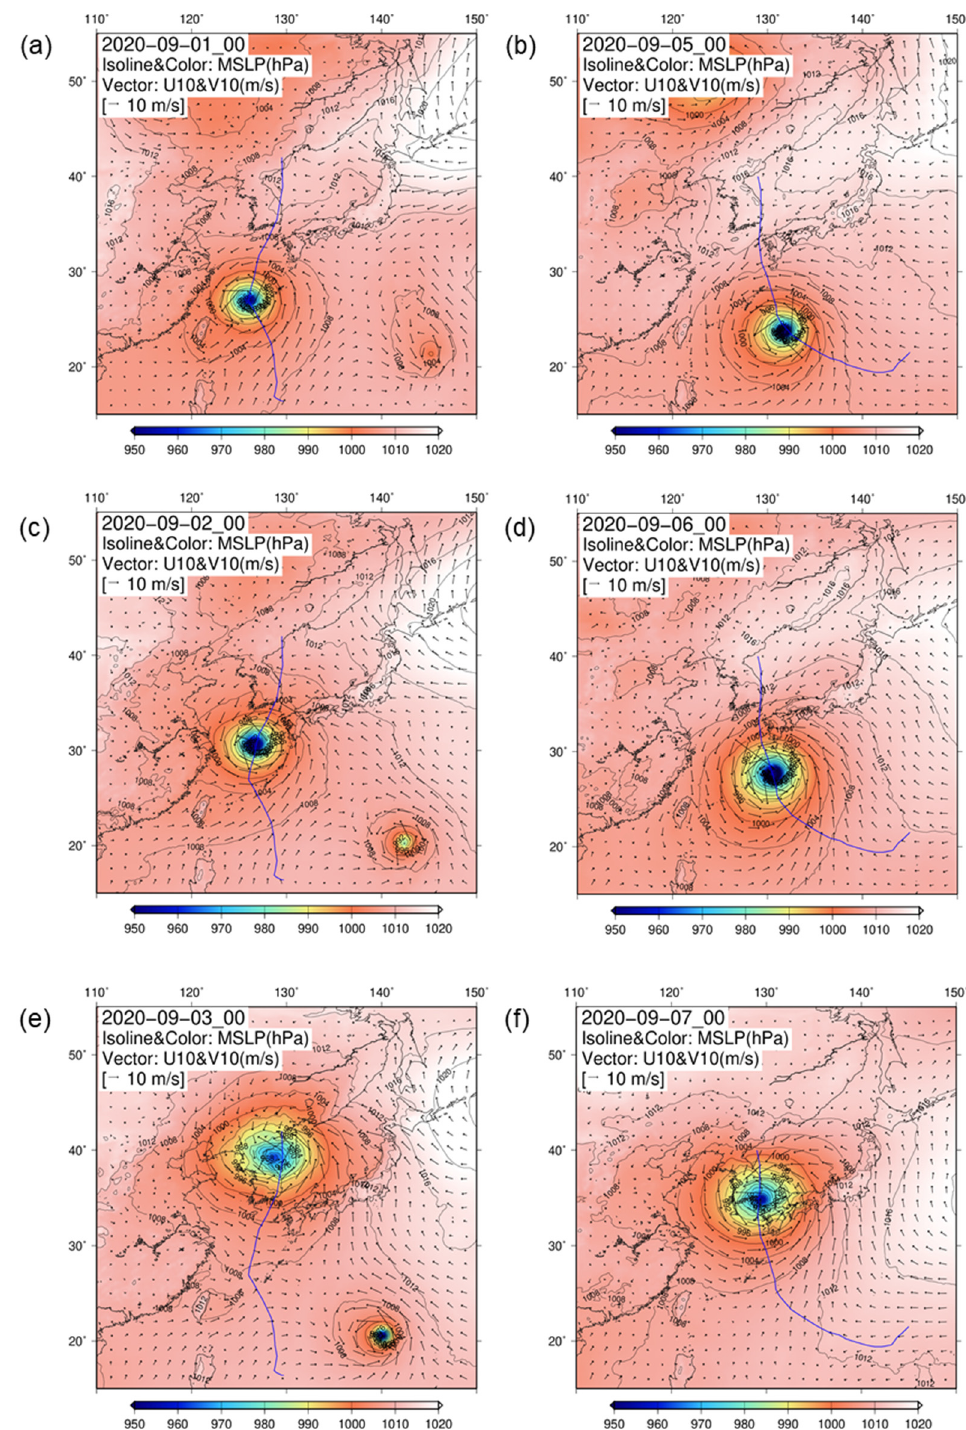
Figure 4. Ten meter wind (arrows) and surface pressure fields (shadings) simulated by MPAS, and the typhoon best track of JTWC (thick blue lines). ( a , c , e ) the forecast result from 00 UTC on 1 September for typhoon Maysak, ( b , d , f ) that from 00 UTC on 5 September for typhoon Haishen.